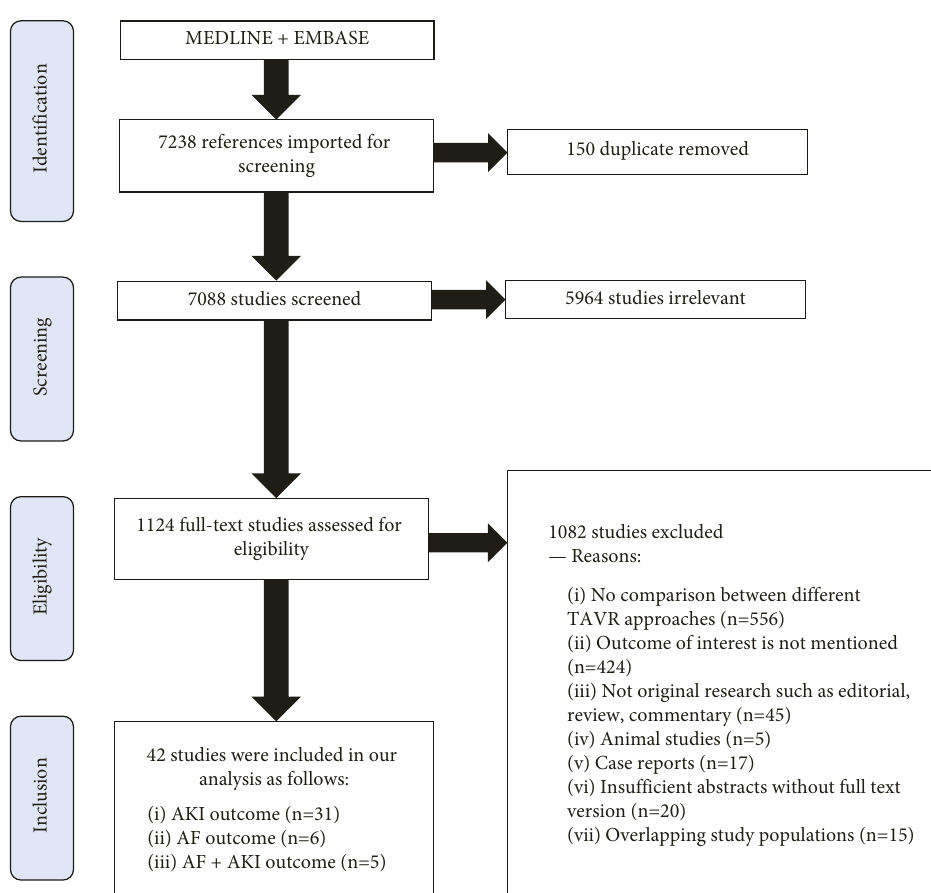
Figure 1: PRISMA flow chart for the systematic review and meta-analysis